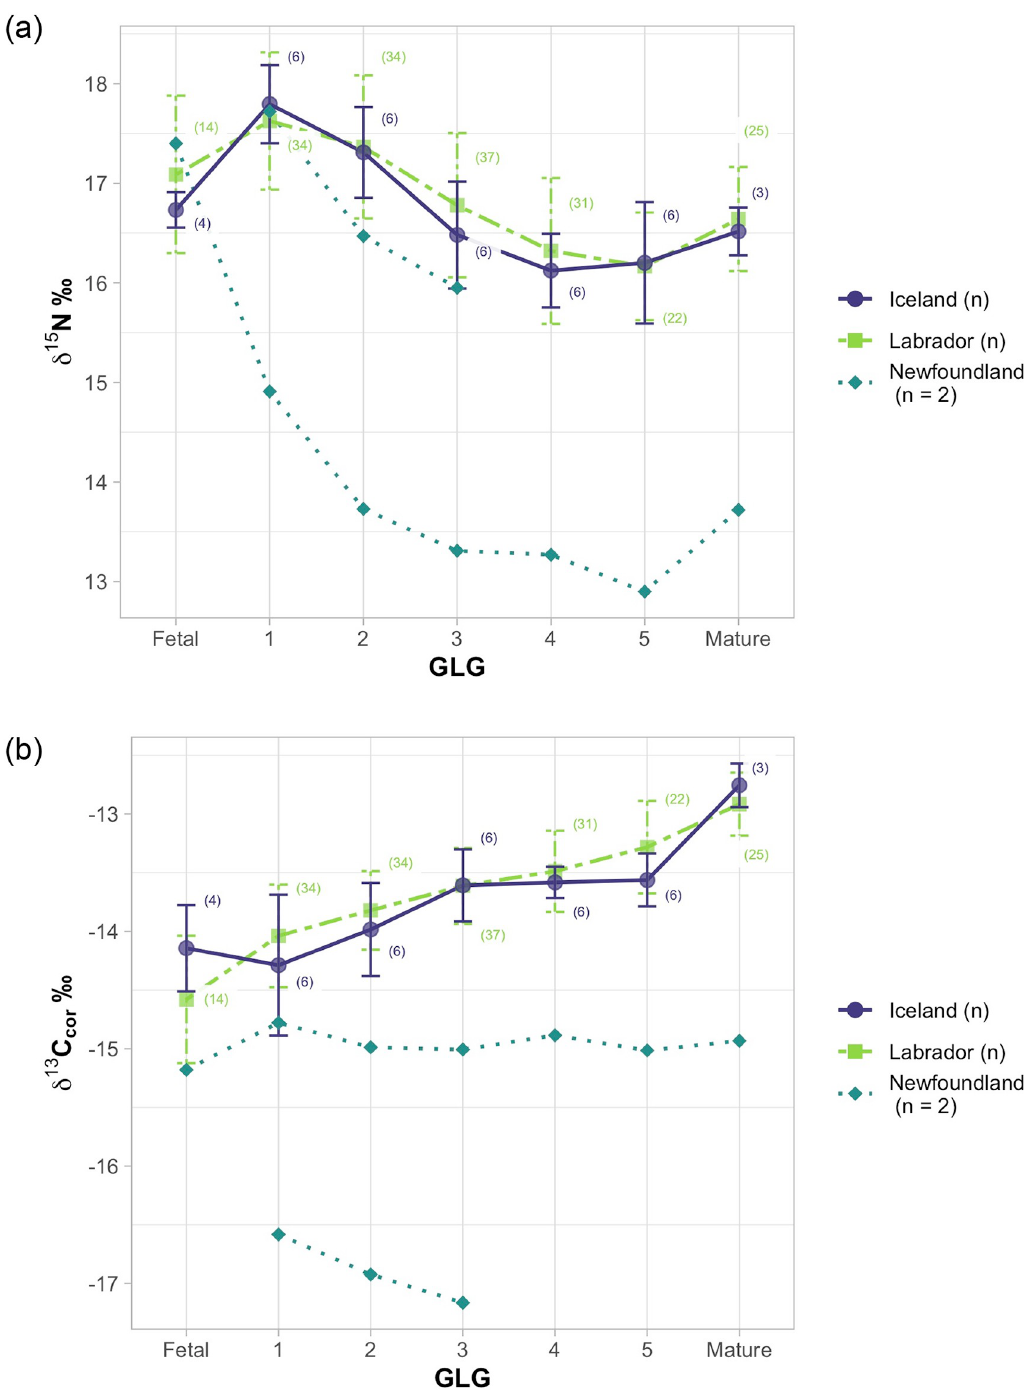
Fig 5. Ontogenetic trends by region for values of (a) δ 15 N and (b) δ 13 C. Purple points and green squares are mean values with standard deviation for Labrador and Iceland, blue diamonds are individual values of two specimens from Newfoundland.